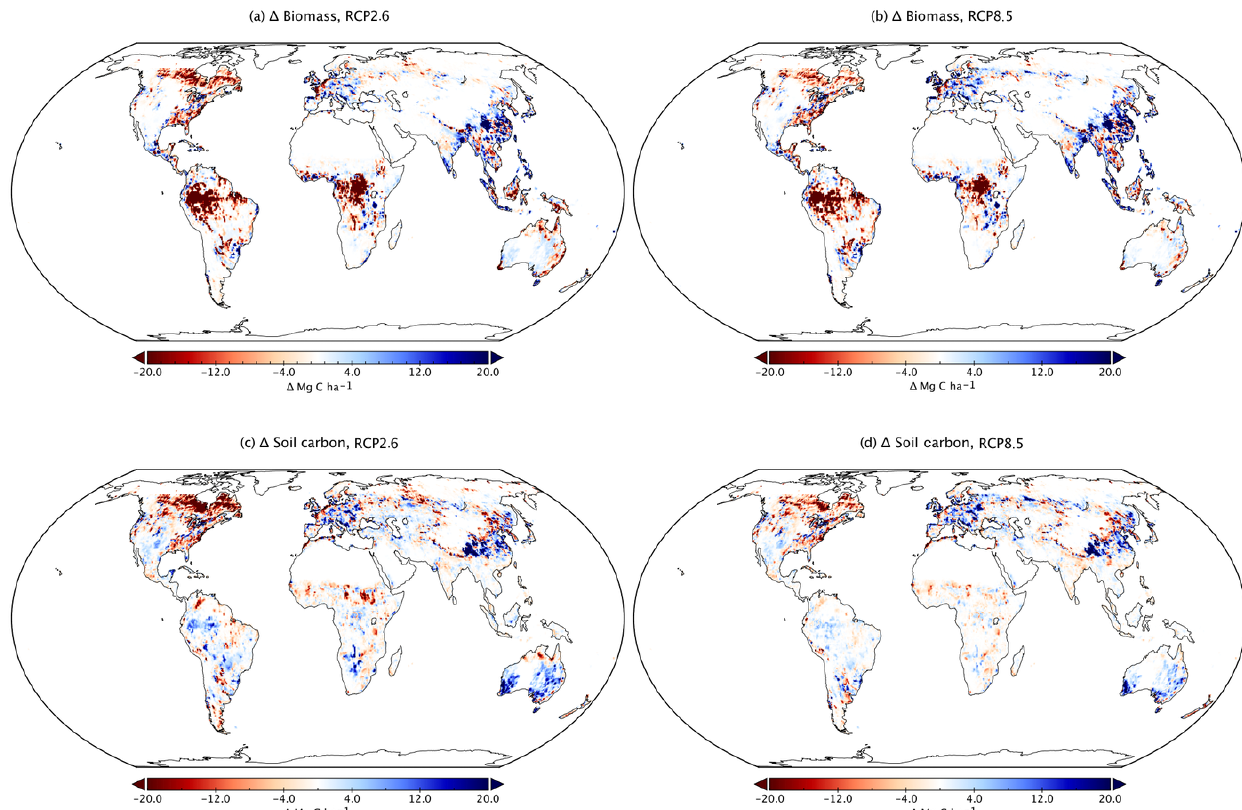
Figure 13. Spatial distribution of land-use change (units: a ratio of the grid box area). The results are for (a, b) food cropland area and (c, d) bioenergy cropland area. Average of the five climate projection-based simulations under (a, c) RCP2.6 and (b, d) RCP8.5 scenarios in the